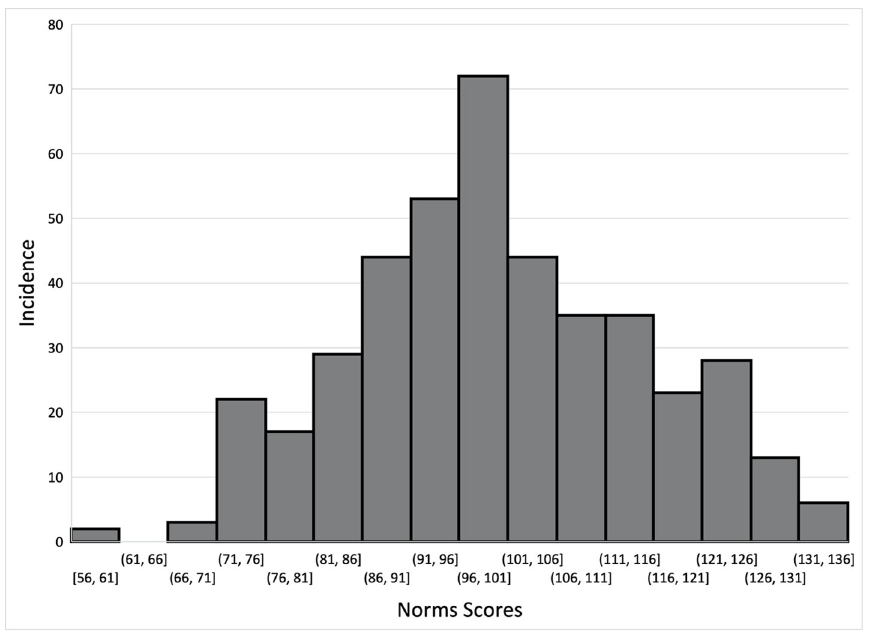
Fig 4. Distribution of norm